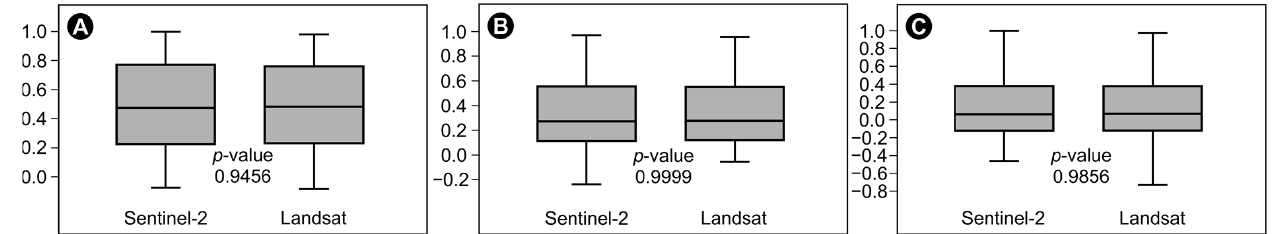
Figure 4. Box plots of S2 and LS harmonized VI datasets: NDVI ( A ); MSAVI ( B ); and NDWI ( C ).